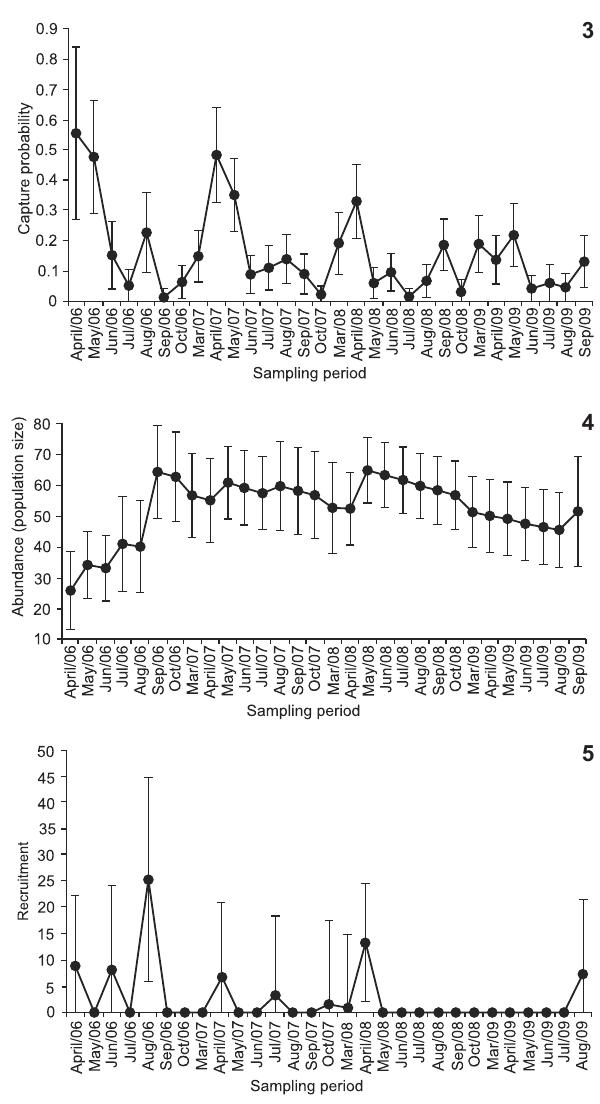
Figure 3-5. Capture probability (3), recruitment (4) and abundance (5) of Megalobulimus paranaguensis in Parque Zoobotânico Orquidário Municipal de Santos (PZOMS) during the study